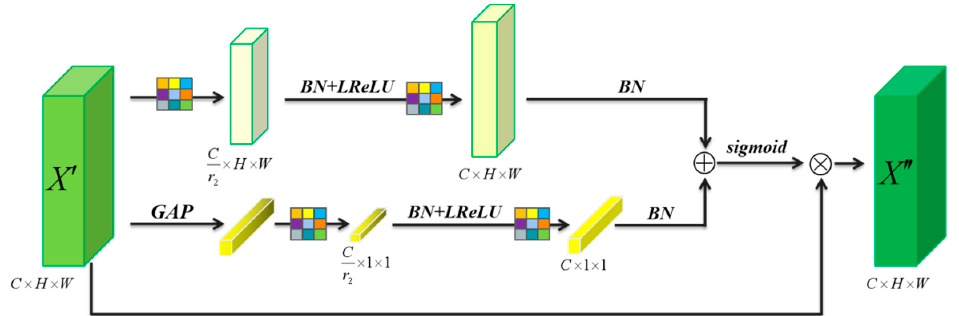
is the channel reduction rate, which can be assigned as (cid:2869) (cid:3045) (cid:3117)